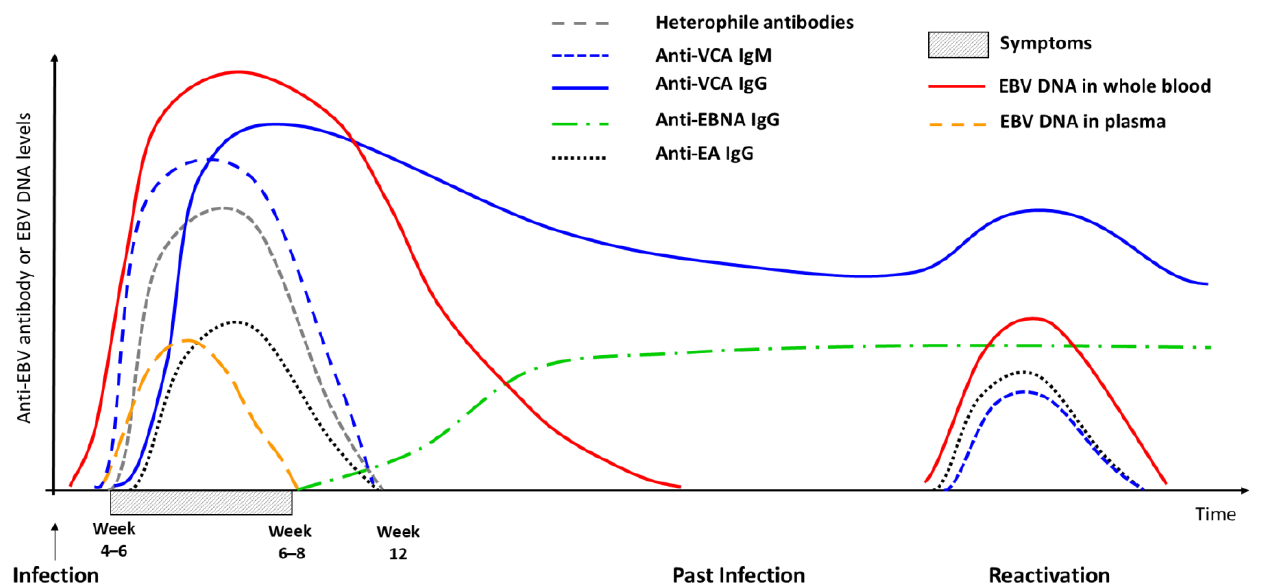
Figure 1. Evolution of antibody and blood EBV DNA markers during EBV infection in an immuno- competent host.